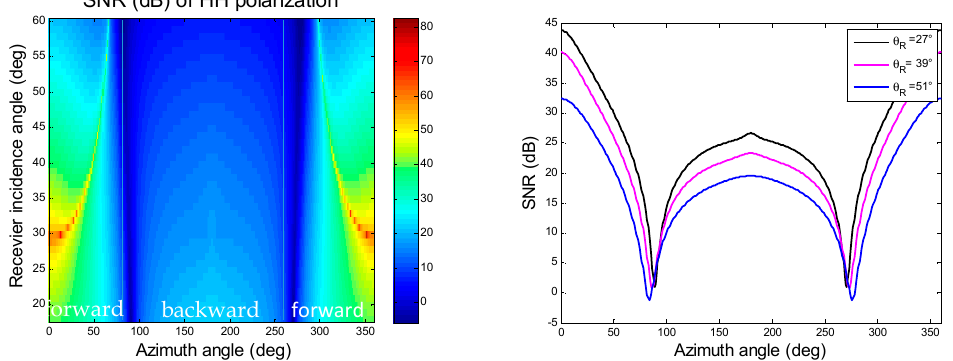
Figure 14. Bistatic scattering coefficients σ 0 and σ 0 at ( a ) ϕ R = 180 ◦ ; ( b ) ϕ R = 0 ◦ θ R = 29.55 ◦ , β = 0 ◦ , l = λ , s = λ /10 with exponential ACF.